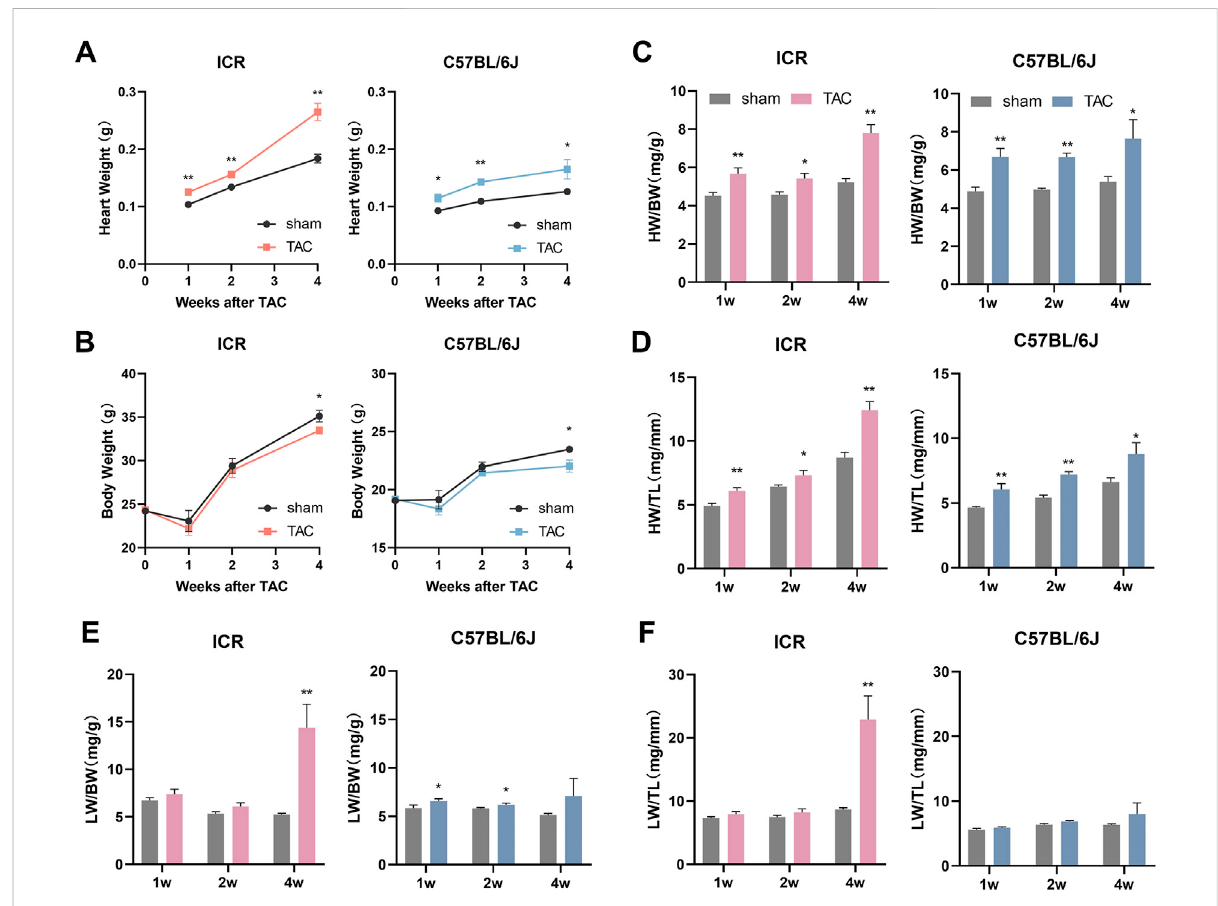
Statistical results of Organ coef fi cients at 1, 2 and 4 weeks post-TAC surgery or sham in ICR and C57BL/6J mice. (A) Heart weight. (B) Body weight. (C,D) Heart weight normalized to body weight (HW/BW) or tibia length (HW/TL). (E,F) Lung weight normalized to body weight (LW/BW) or tibialength(LW/TL).Dataareshownasmean±SEM, N =6 – 8perICRgroup, N =6 – 9perC57BL/6Jgroup.* p < 0.05,** p < 0.01vs.theirspeci fi csham